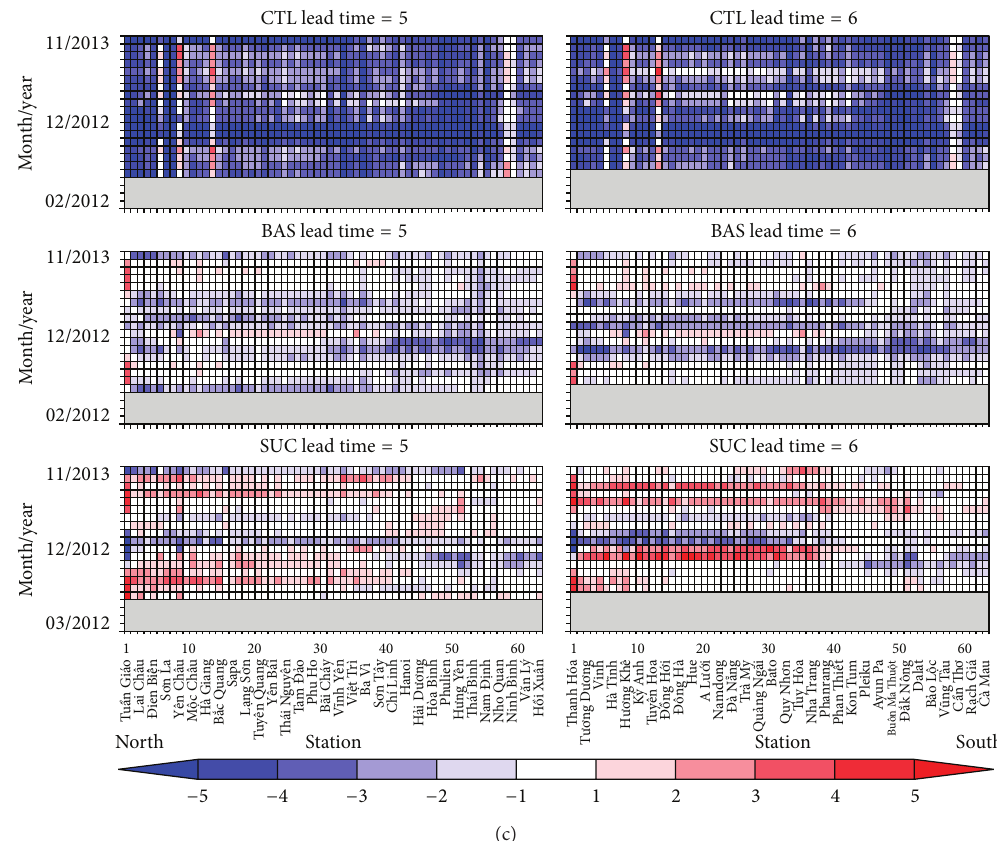
Figure 5: (a) The T2m forecast errors (model minus observation) at 64 stations for lead times of 1 and 2 months for the CTL (top), BAS (middle), and SUC (bottom) experiments. Vertical axis indicates target months. The numbers in horizontal axis indicate 64 stations in the order from North to South. The names of stations in the corresponding order are placed at the bottom of the figure. (b) Same as (a) but for lead times of 3 and 4 months. (c) Same as (a) but for lead times of 5 and 6 months.